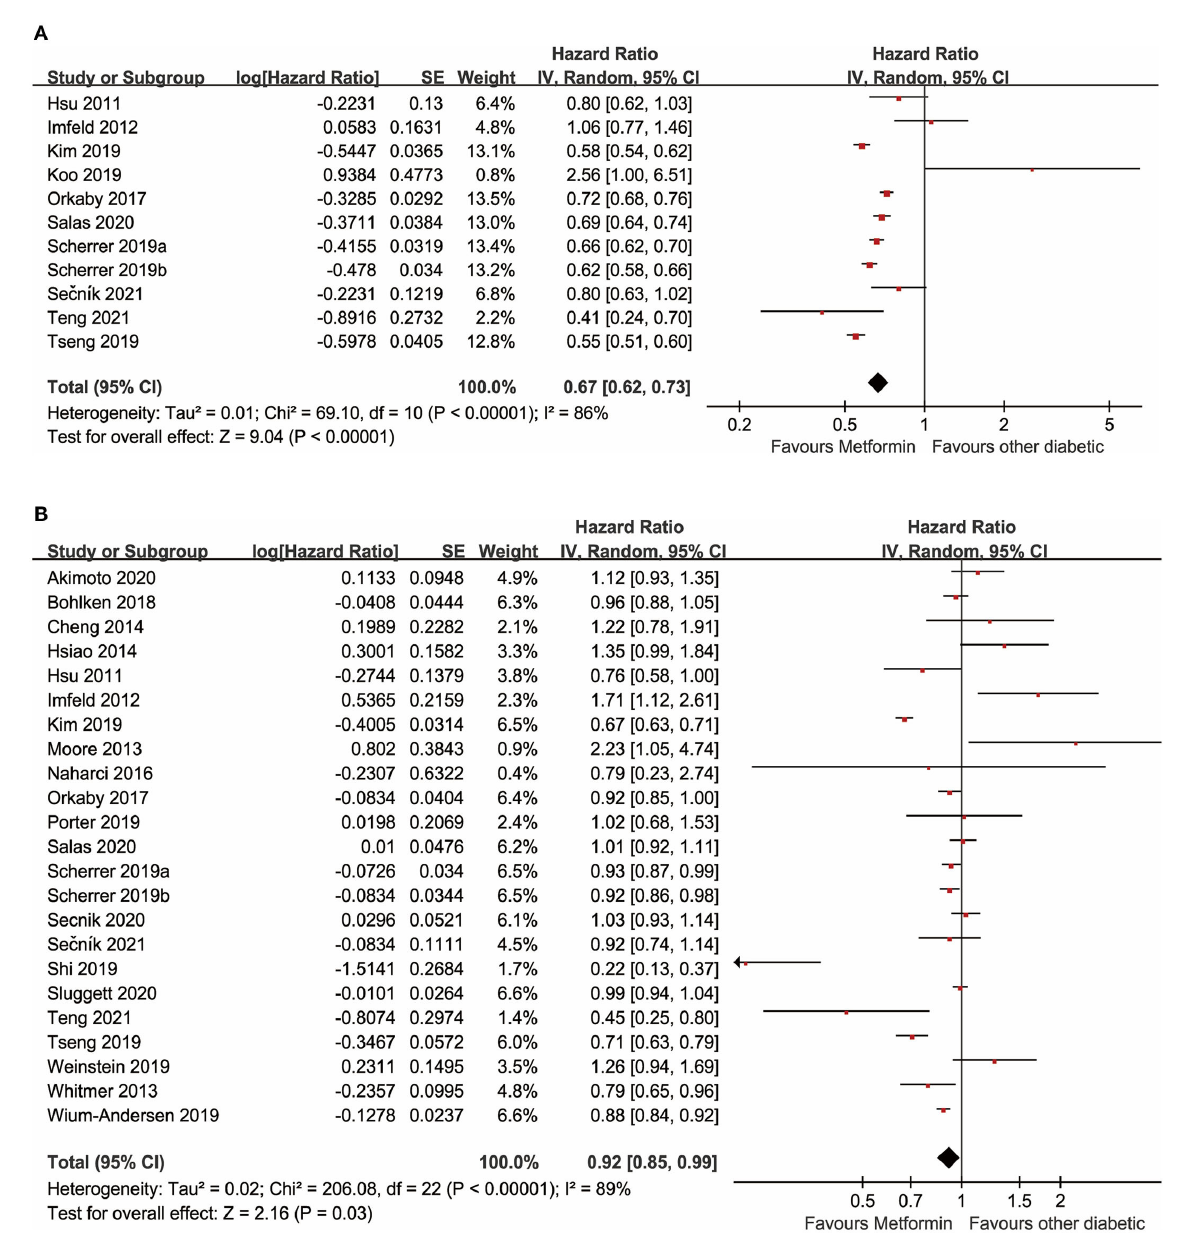
FIGURE2 (A) Meta-analysis of unadjusted covariates between metformin and the occurrence of cognitive dysfunction. (B) Meta-analysis of adjusted covariates between metformin and the occurrence of cognitive